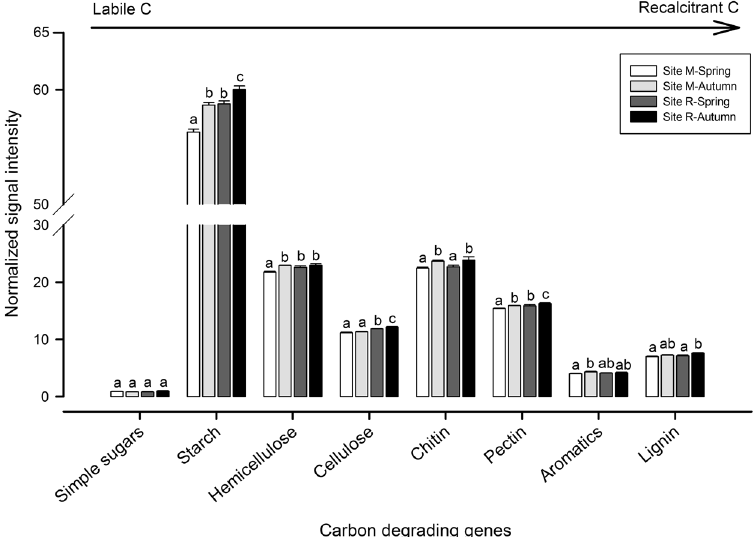
Figure 5. Normalized signal intensities for key C degrading genes detected using Geochip 5.0 and found at the deciduous forest site M (545–570 m asl) and the coniferous forest site R (1,724–1,737 m) in spring and autumn. The genes were grouped according to the different substrates. The targeted substrates were arranged in order from labile to recalcitrant C. For each substrate, values followed by different letters are significantly different (p ≤ 0.05) according to Tukey’s HSD test. Bars represent standard deviation.